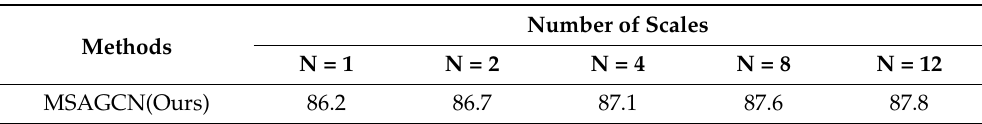
Table 1. Recognition accuracy (%) with different scale aggregation on X-sub benchmarks of the NTU RGB+D